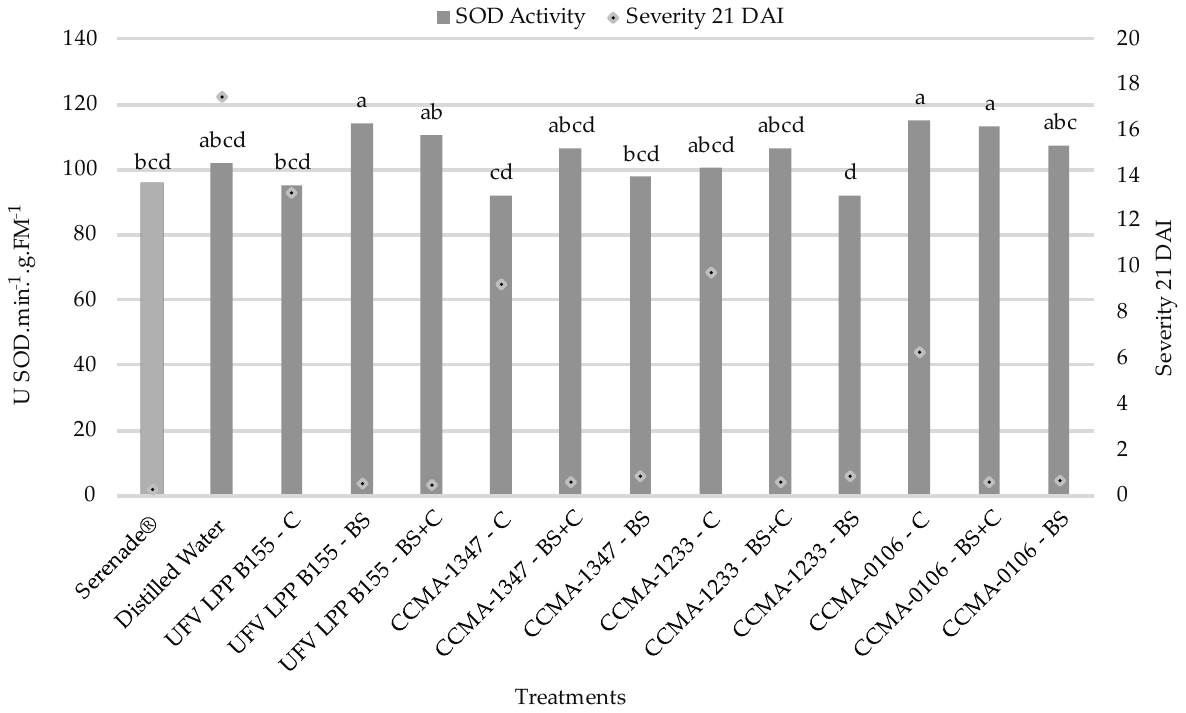
Figure 4. ( a ) Soybean plant treated with B. subtilis strain LPP B155 in a formulation containing cells and biosurfactants at 21 DAI (T5); ( b ) the first pair of leaves above the cotyledons in plants treated with strain LPP B155 in a formulation containing only bacterial cells at 21 DAI. SOD activity (Figure 5) remained almost constant in all treatments. Treatments with the B. subtilis strain LPP B155, where only cells (C) or only biosurfactant (BS) were applied, showed differences in enzyme activity, where BS led to higher SOD activity when com- pared to C and the combination BS + C led to intermediate values of activity of this en- zyme. In BS and BS + C for LPP B155, there was no statistical difference in SOD activity or disease severity, which increased once the biosurfactants were removed. For CCMA-1233 ( B. licheniformis ), the lack of bacterial cells (BS) led to an evident reduction in SOD activity, the opposite of severity, which increases when biosurfactants are removed from the for- mulation. Treatments based on the P. aeruginosa strain CCMA0106 showed higher values of enzymatic activity even in the absence of cells (BS), but the absence of biosurfactants leads to an increase in rust severity.